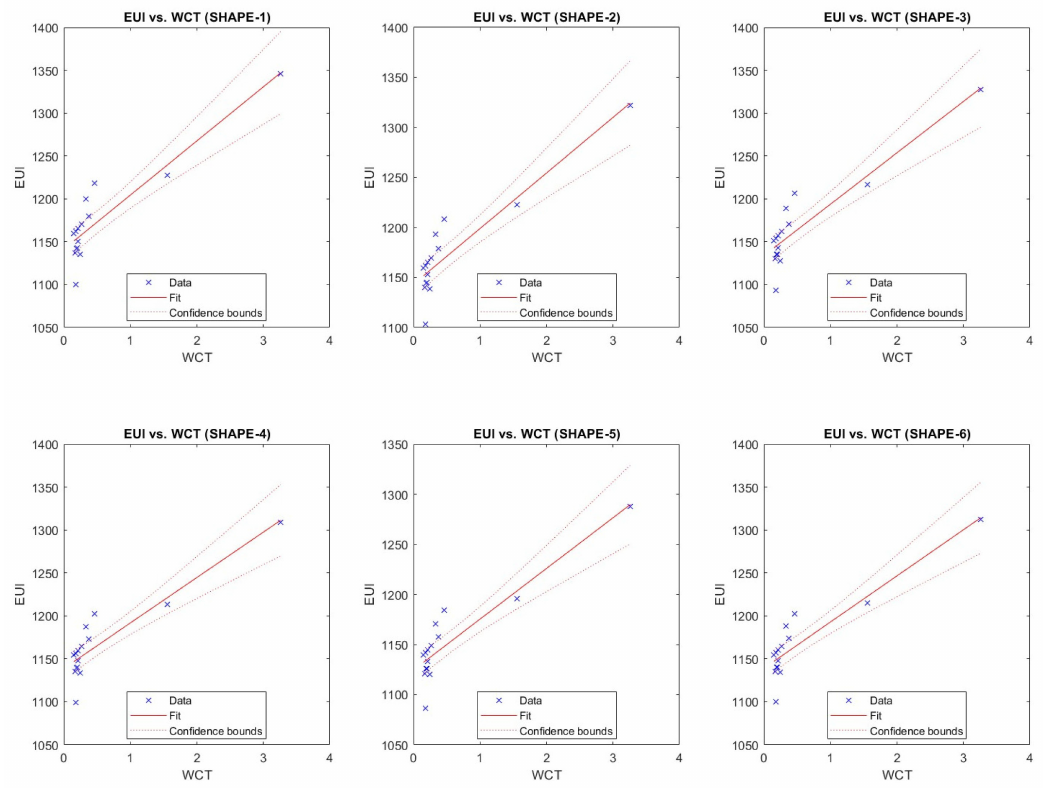
Figure 13. Fitted lines of wall construction type